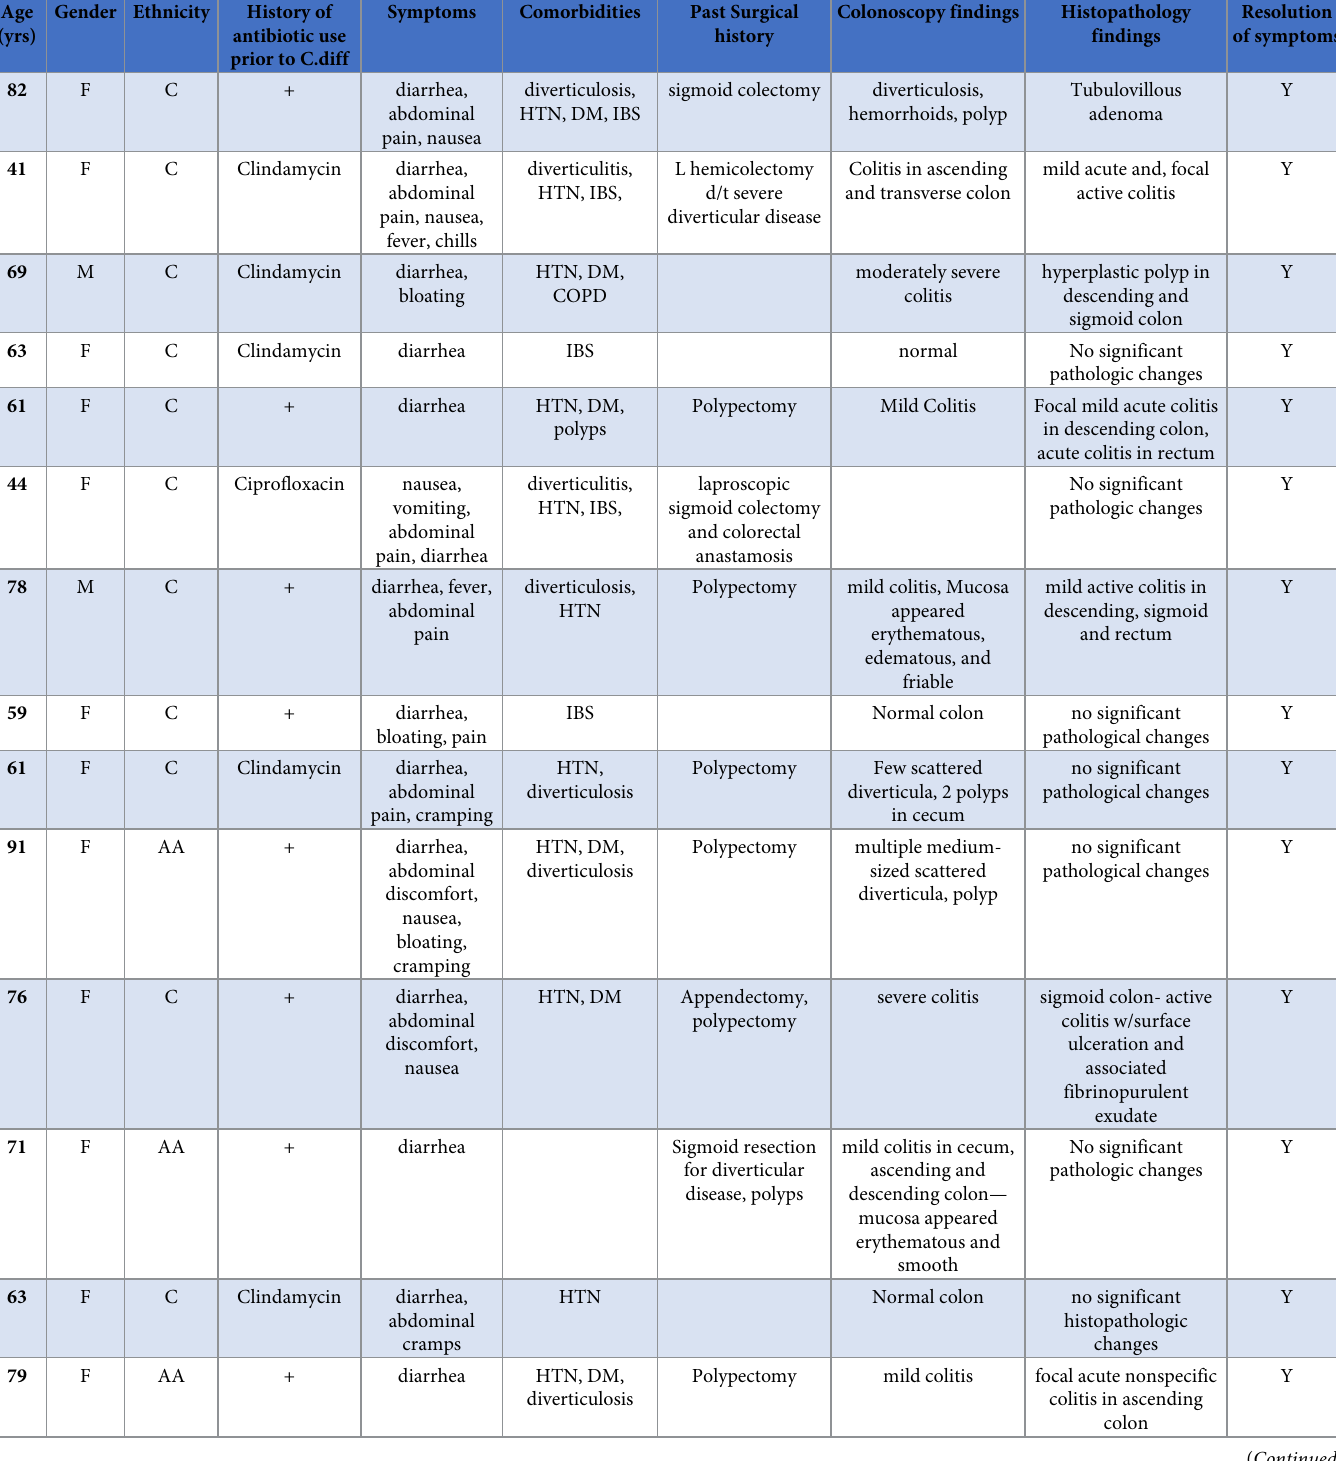
Table 1. Table detailing clinical characteristic of patients with RCDI. Age Gender (yrs)